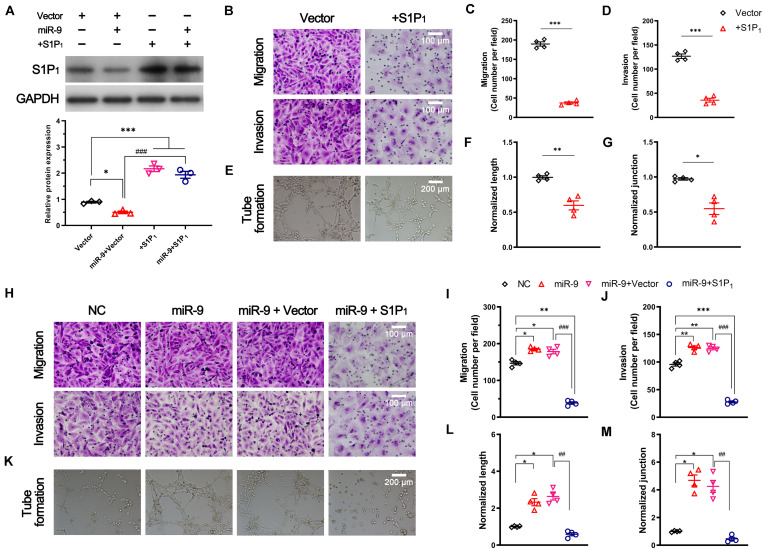
Effect of S1P1 on angiogenesis. Cells were transfected with pcDNA3.1 vector expressing S1P1 (+S1P1) or pcDNA3.1 vector (vector). For the rescue assay, cells overexpressing miR-9 were transfected with pcDNA3.1 vector expressing S1P1 (miR-9 + S1P1) or pcDNA3.1 vector (miR-9 + vector). After transfection for 48 h, the protein level, migration, invasion and in vitro angiogenesis were performed. (A) Western blot of S1P1 and quantification. Mean ± SEM. n = 3, *P < 0.05, ***P < 0.001. ###P < 0.001. (B–D) Transwell assays (B) of migration (top) and invasion (bottom) of HUVECs overexpressing S1P1 in response to 50 ng/mL hVEGF. Mean ± SEM, n = 4. ***P < 0.001. (E–G) Tube formation (E), normalized tube length (F), and number of junctions (J) formed by HUVECs overexpressing S1P1 in response to 50 ng/mL hVEGF. Mean ± SEM, n = 4. *P < 0.05, **P < 0.01. (H–J) Transwell assays (H) of migration (top) and invasion (bottom) of HUVECs overexpressing miR-9 and S1P1. NC: miR-9 mimics negative control. Mean ± SEM, n = 4. *P < 0.05, **P < 0.01, ***P < 0.001; ###P < 0.001. (K–M) Tube formation (K), normalized tube length (L), and the number of junctions (M) formed by HUVECs overexpressing miR-9 and S1P1. NC: miR-9 mimics negative control. Mean ± SEM, n = 4. *P < 0.05; ##P < 0.01.